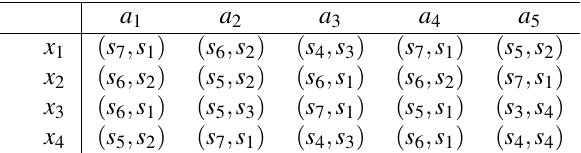
Table 1. Decision matrix R 1